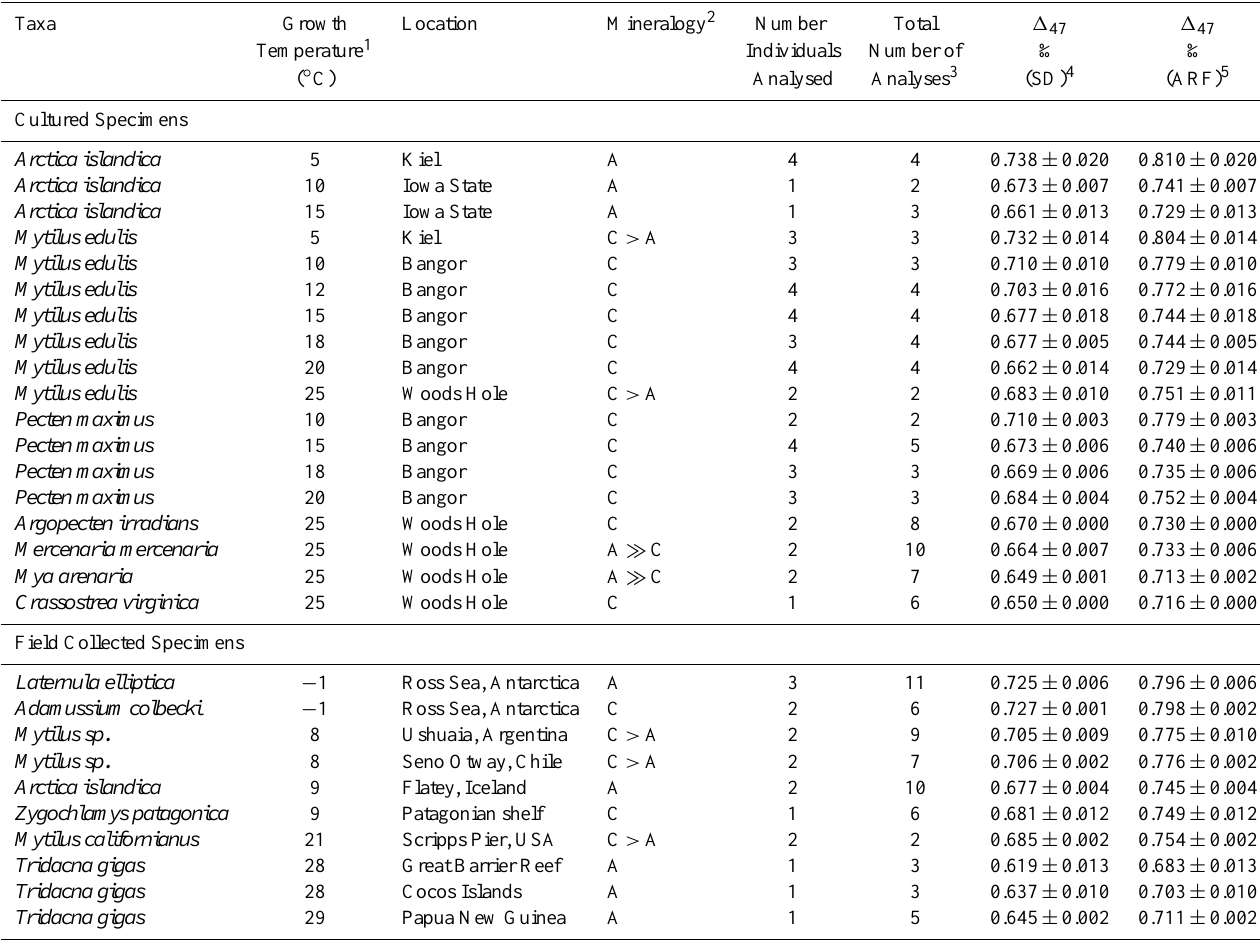
Table 2. Average stable isotope data for all mollusk samples grown at seawater in equilibrium with present day p CO 2 .